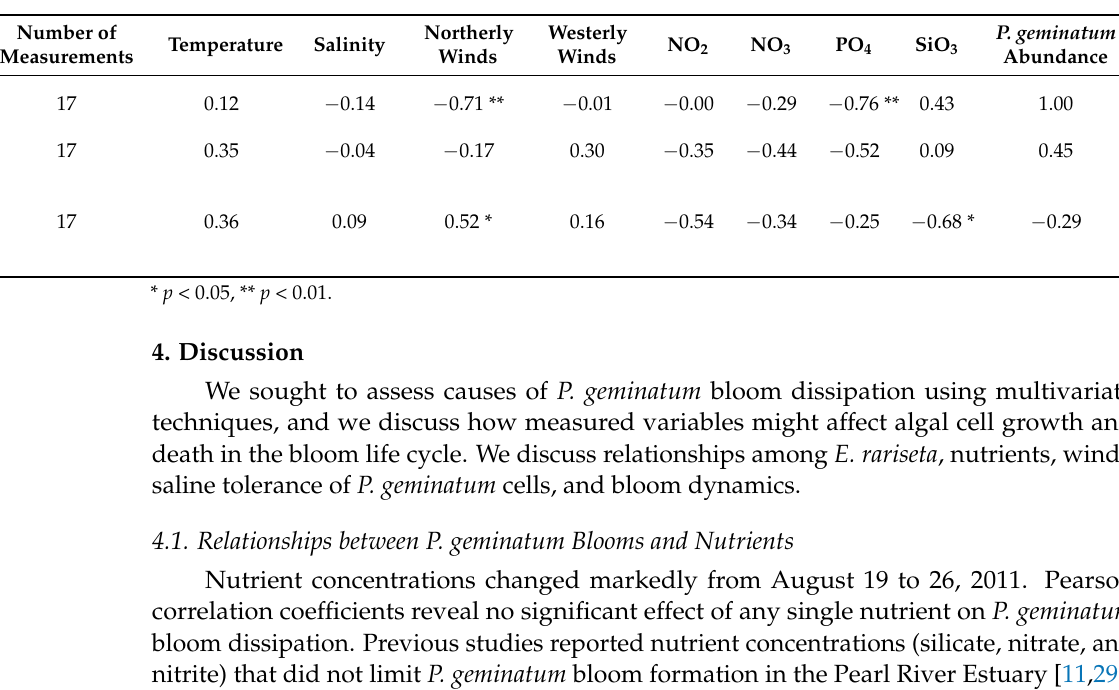
Table 3. Standardized regression coefficient and significance between P. geminatum , ciliate, tempera- ture, salinity, and